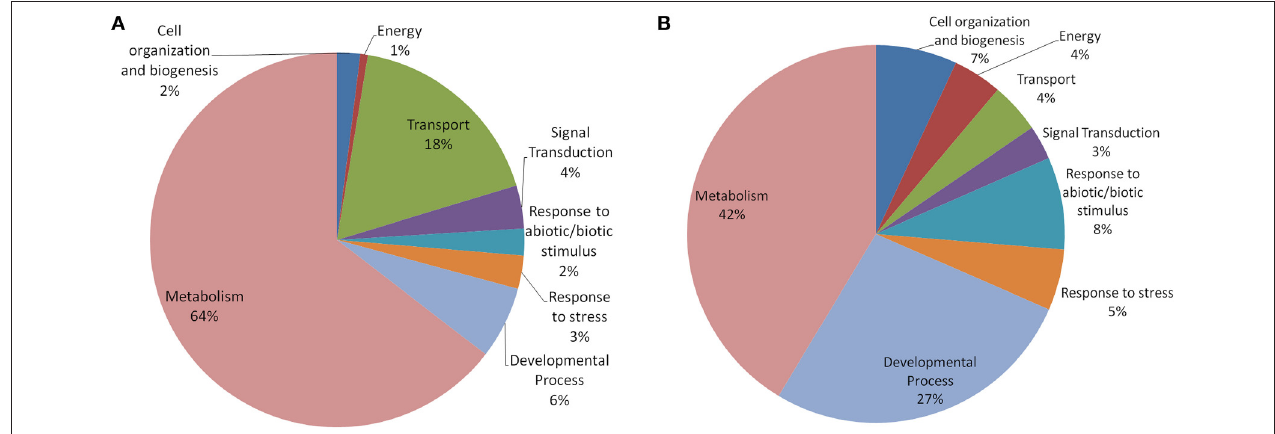
FIGURE 5 | The pie-chart of the biological processes in which the old “prokaryotic” proteins were found to be involved in Arabidopsis (A) and Oryza sativa (B). The ontologies of the old “prokaryotic” proteins were obtained using the GOSlim assignments for both Arabidopsis and Oryza sativa . The chart shows the processes in which old “prokaryotic” proteins are involved have got diversified in Oryza sativa